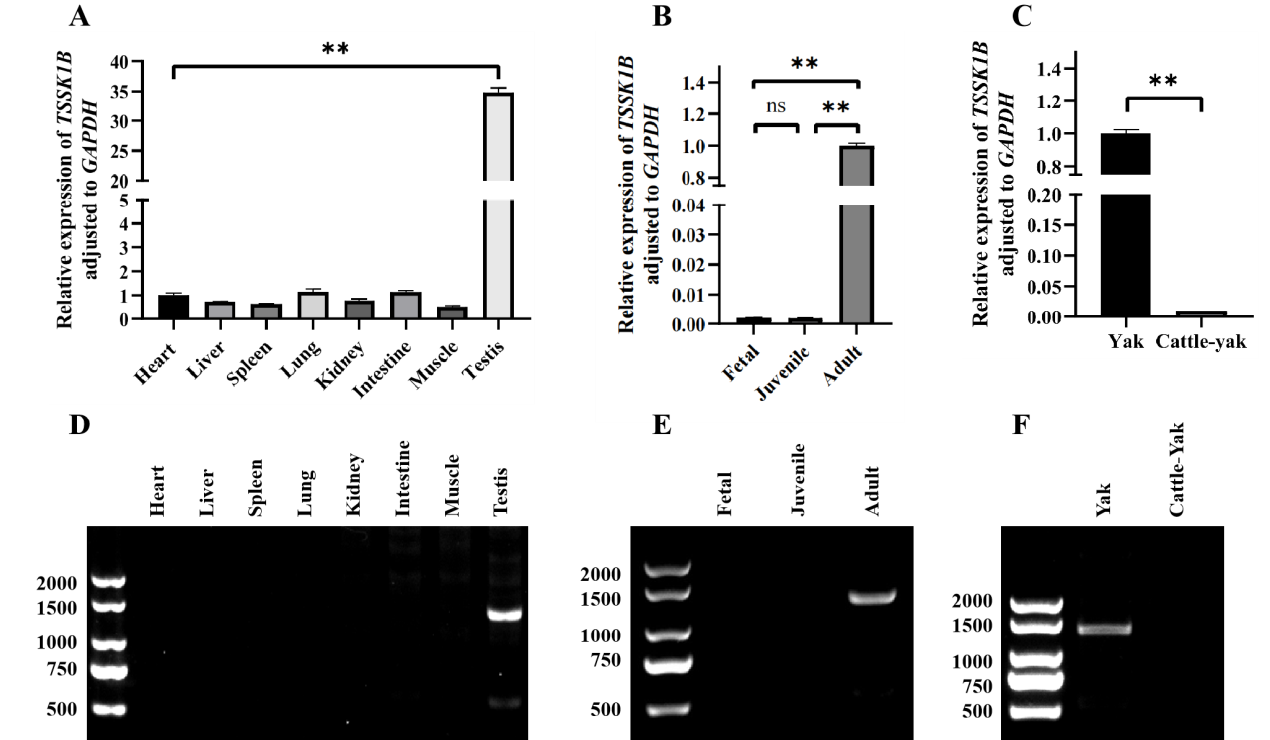
Figure 4. The expression pattern of TSSK1B gene in tissues of yak and cattle – yak based on the RT-PCR and RT-qPCR. ( A ) The expression level of TSSK1B gene in eight tissues of adult male yaks. ( B ) The expression level of TSSK1B gene in yak testis from different growth stages. ( C ) The expression level of TSSK1B gene in testis of adult yak and cattle – yak. ( D ) The amplification product of TSSK1B in adult male yak tissues detected by agarose gel electrophoresis. ( E ) The expression level of TSSK1B in different ages of yak testis, as detected by agarose gel electrophoresis. Analysis of TSSK1B expression by RT-PCR in different tissues. ( F ) The electrophoresis figure that reflected the expression level of TSSK1B between adult yak and cattle – yak testes. ** represents p < 0.01 and “ns” means there is no significance.